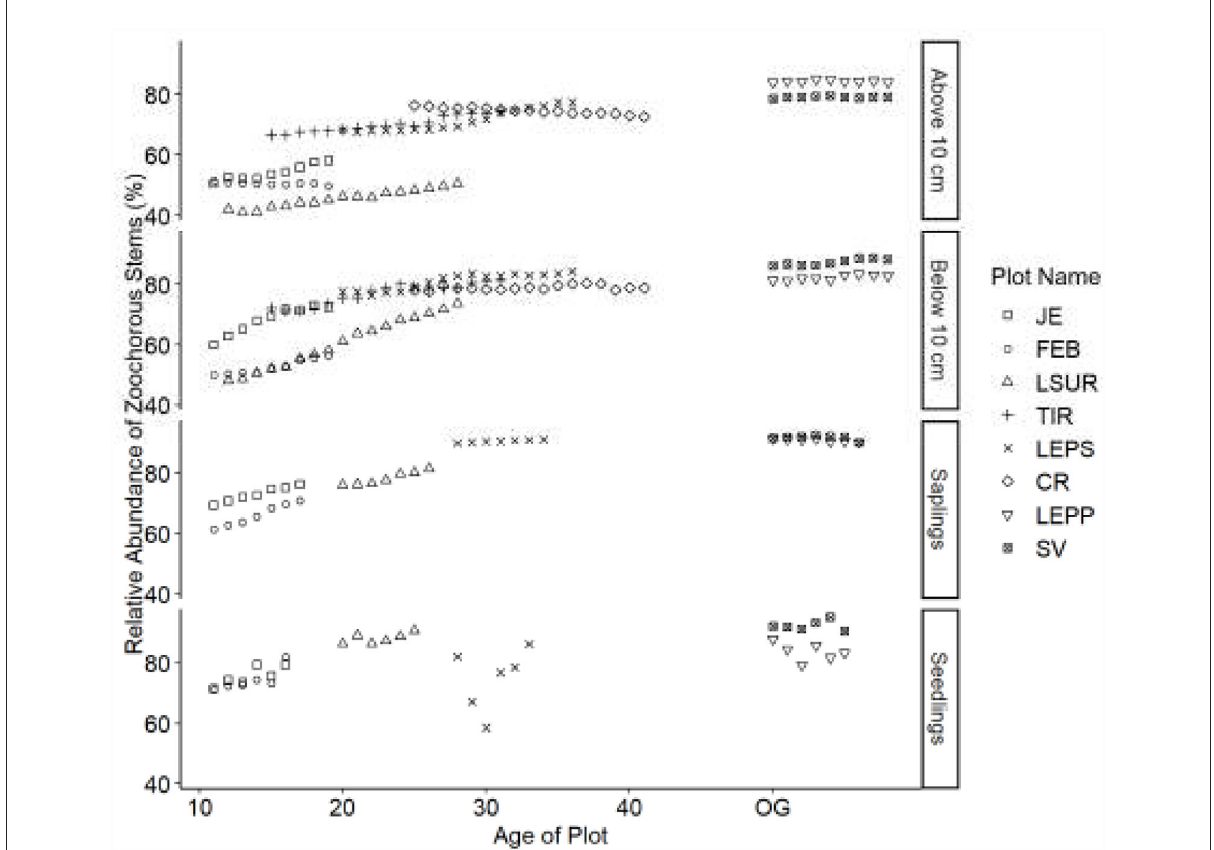
FIGURE2 Relative abundance of zoochorous stems. Table 1 indicates the plot acronyms, which appear from youngest to oldest, top to bottom in the